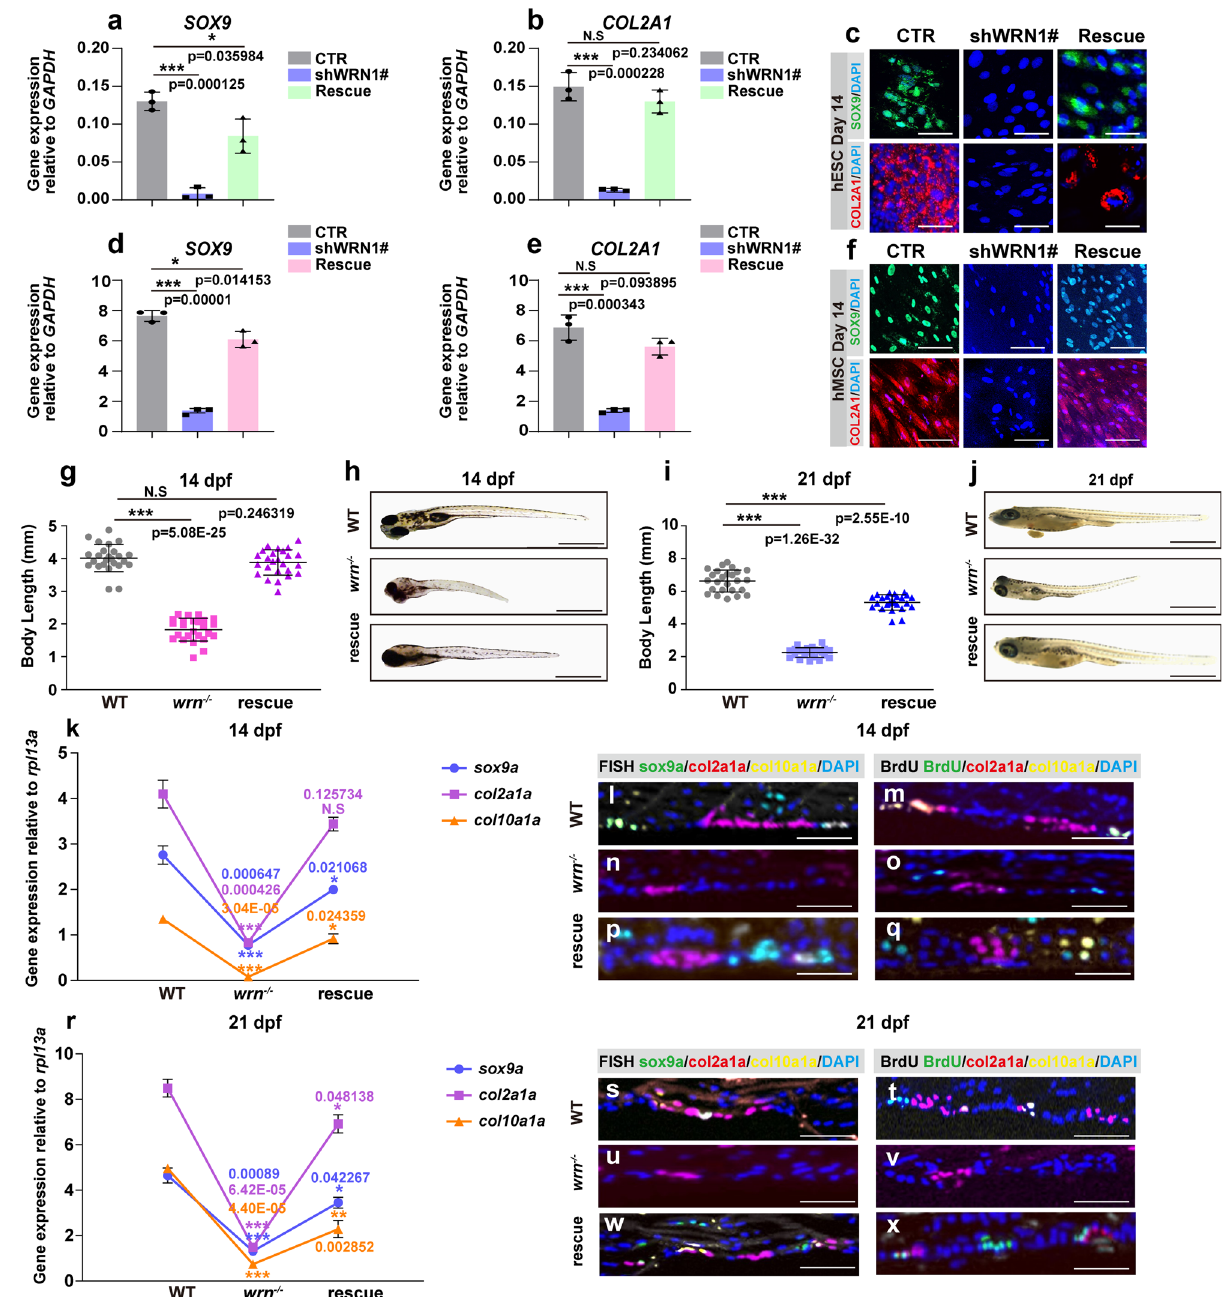
Fig. 7 | SHOXrestoreschondrogenesisinWS. a , b , d , e qRT-PCR measurement of the expression of SOX9 and COL2A1 among CTR, shWRN1#, and rescue groups during chondrogenesis on day 14 in hESCs and hMSCs. N =3 independent biolo- gical experiments. c , f Representative immuno fl uorescent staining of 3 indepen- dentexperimentsamongCTR,shWRN1#,andrescuegroupsonday14inhESCsand hMSCs.SOX9andCOL2A1wereexamined.Scalebar=50 µ m. g , i Dotgraphanalysis of thetotalbodylengthamong WT, wrn − / − mutant,andrescuegroupson14dpf( h ) and 21dpf ( i ). N =25 independent zebra fi sh embryos for WT, wrn − / − mutant, and rescue groups, respectively. Each dot represents a biological